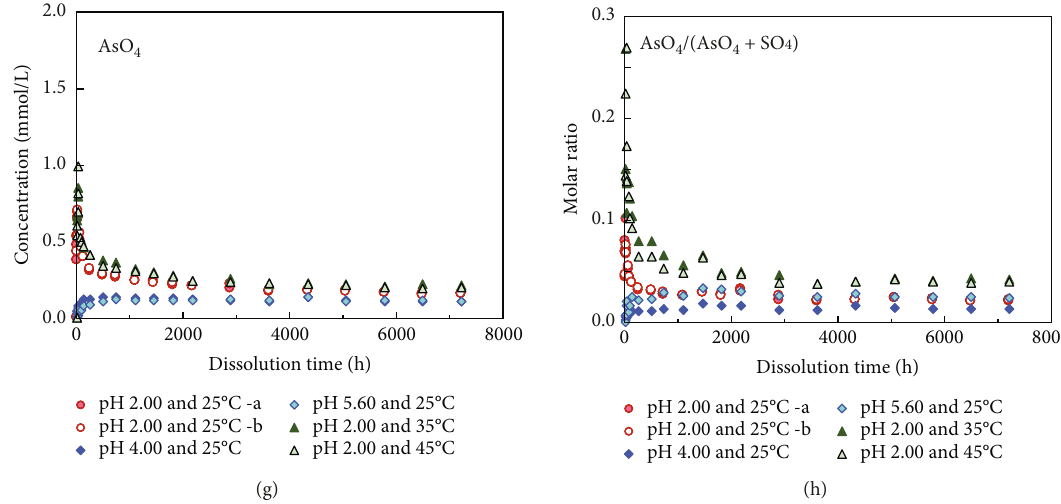
Figure 5: Aqueous evolution during the dissolution of the synthetic arsenic-incorporated natroalunite at 25–45 ° C for